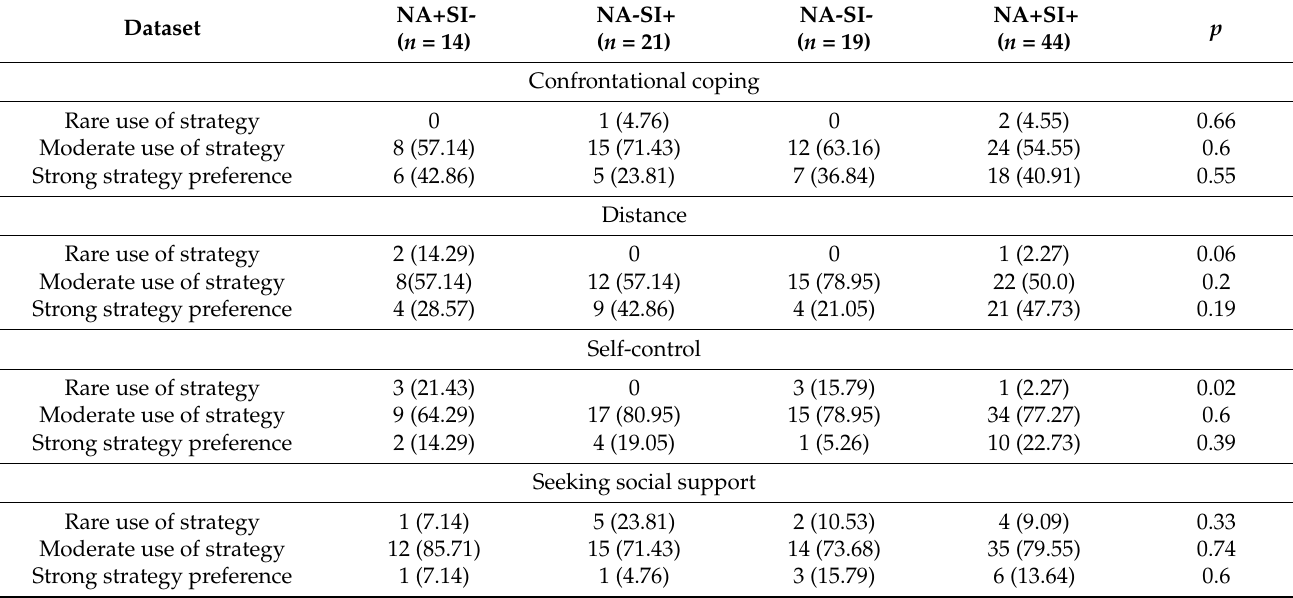
Table 2. Ways of Coping Questionnaire (WCQ),